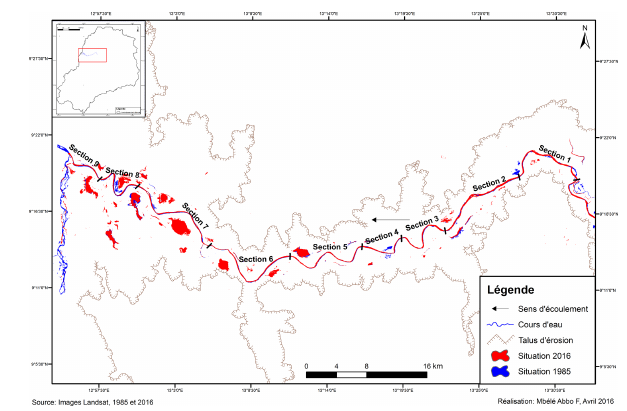
Figure 3. Visualisation des différentes sections d’analyse du tron- çon